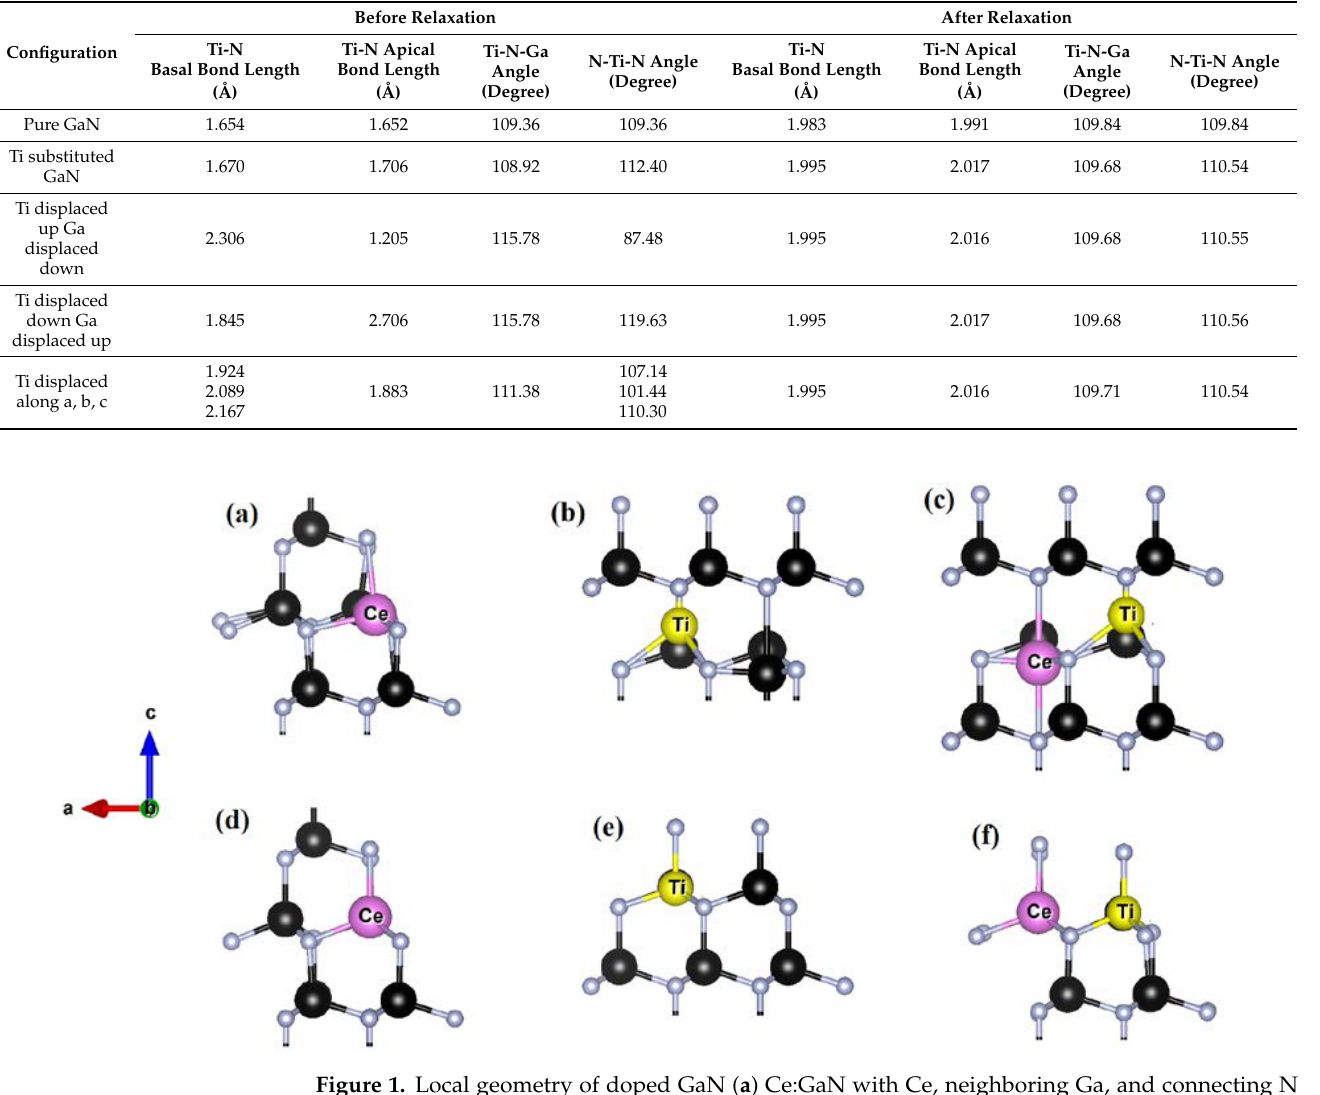
Table 1. Calculated structural parameters before and after relaxation for pure GaN, Ti substituted GaN, Ti, Ga placed off-cationic sites in Ti:GaN.